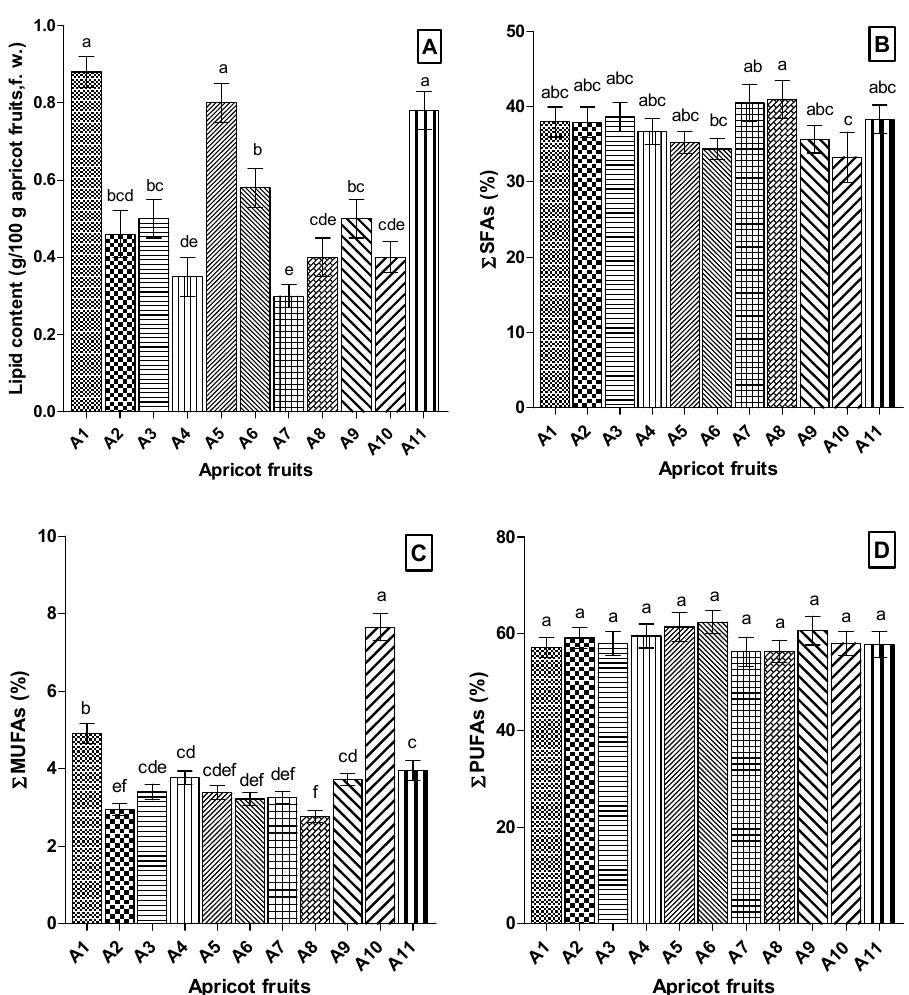
Figure 2. Comparative representation of total lipid contents ( A ) and fatty acid classes of apricot fruit samples: ( B ) SFAs, saturated fatty acids; ( C ) MUFAs, monounsaturated fatty acids; ( D ) PUFAs, polyunsaturated fatty acids. Values are the mean ± SD of three samples, analyzed individually in